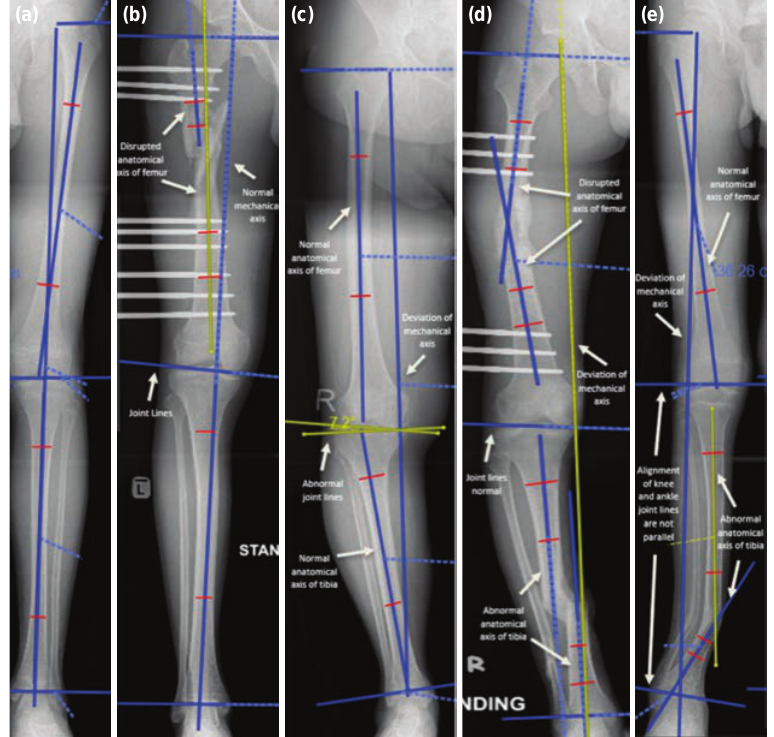
(a) Normal mechanical axis, normal anatomical axis for both tibia and femur with parallel mJLCA (all four imaginary lines are Fig. 2: parallel to each other). In this case, the femur, tibia and joint are all normal, provided there is no shortening compared to the contralateral leg. (b) Normal mechanical axis but abnormal anatomical axis of either femur or tibia bone. The mJLCA may be normal. This indicates femur or tibia compensated deformity. (c) Abnormal mechanical axis, normal anatomical axis for both tibia and femur with disrupted mJLCA. This indicates deviated mechanical axis secondary to joint pathology. (d) Abnormal mechanical axis, abnormal anatomical axis of either femur or tibia bone with normal mJLCA. In this case, the pathological bone is causing the mechanical axis deviation. (e) The mechanical axis deviation and disrupted modified joint line convergence angle (mJLCA) is due to the tibial